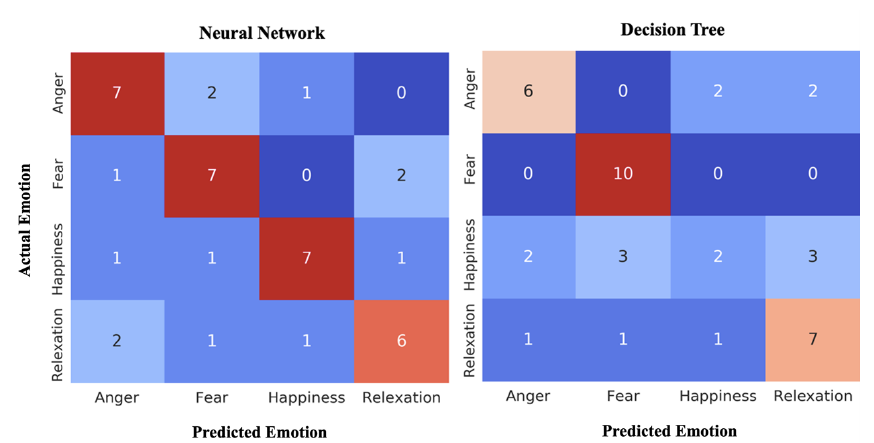
Figure 13. Confusion matrices of the neural network and decision